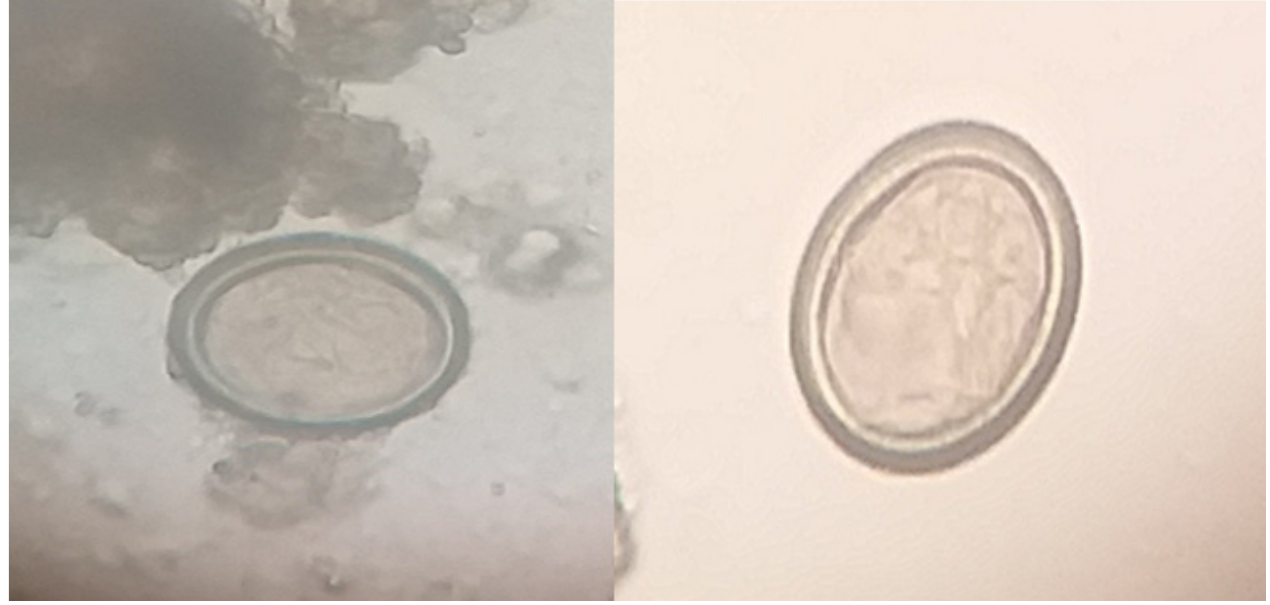
Figure 1. Taeniid eggs ( Echinococcus granulosus ) detected in dog faecal samples (sedimentation technique) 100 × .